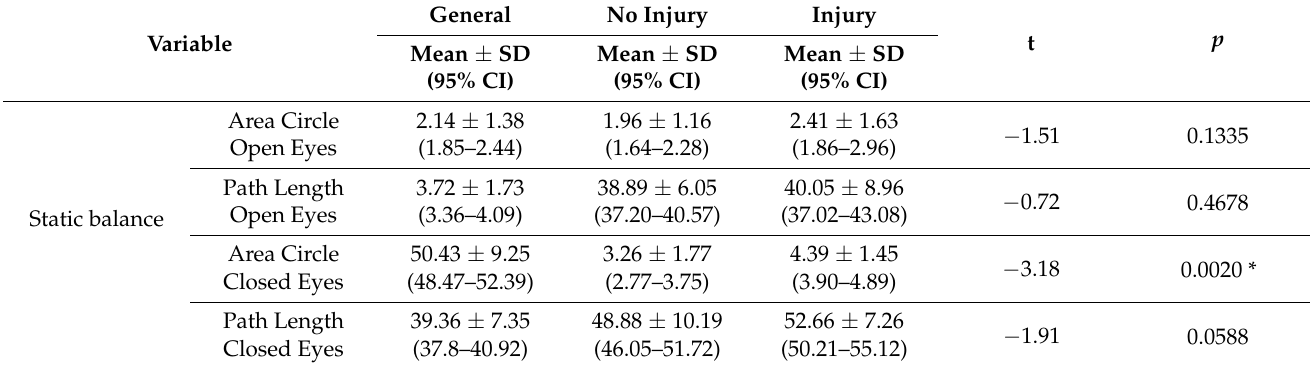
Table 1. Student’s t -test comparison static balance test results.